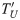
The online pipeline.Three stages exist: training, calibration and testing. During training, responses X to stimuli from V are recorded. During calibration, X is deconvolved to pulse responses r using V. Template responses T
V and T
U are generated by convolving these r with the bit-sequences V and U, respectively. Templates are multiplied (circles) with filters (W
X, W
T) designed by CCA. The subset and layout are optimized giving U′ and TU′, and stopping margins m are learned. In the testing phase, a new single-trial x is assigned the class-label y that maximizes the correlation between the spatially filtered single-trial x and templates TU′. The classifier emits the class-label if the maximum correlation exceeds the threshold margin. In the case wherein the margin is not reached, more data is collected.